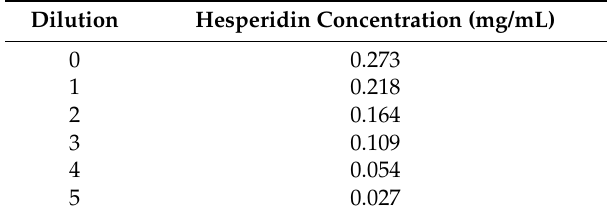
Table 3. Initial concentrations for the adsorption efficiency tests.